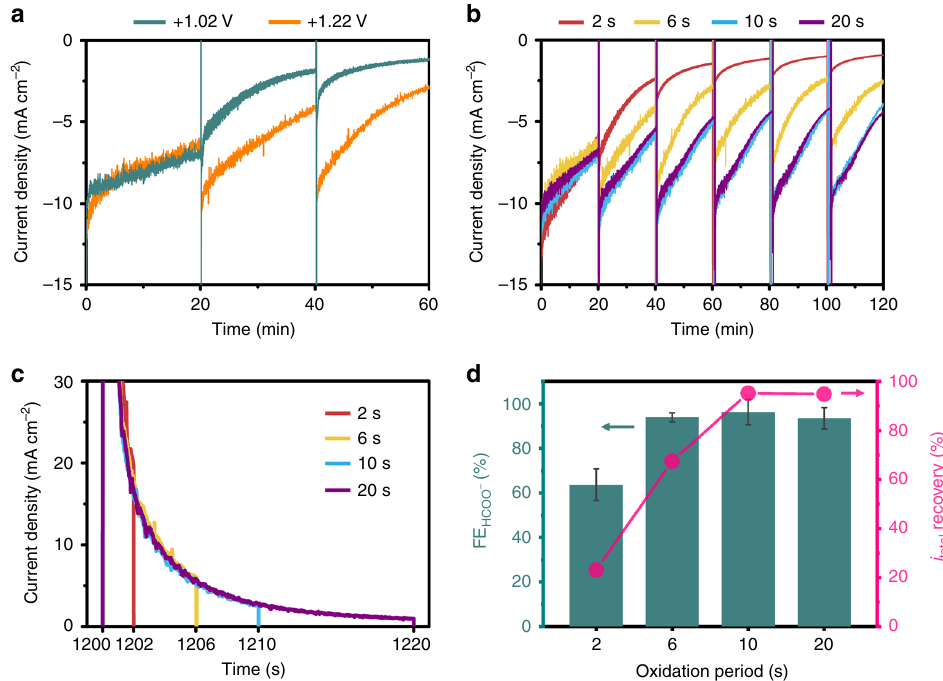
Fig. 4 Key parameters of cyclic two-step electrolysis. a The effect of oxidation potential on current density recovery. The oxidation potential was changed with the oxidation period fi xed at 6 s. b Current density vs. time curves as a function of oxidation period. The oxidation period was varied from 2 to 20 s while the oxidation potential was fi xed at 1.22 V vs. RHE. In controlling the oxidation parameters, the reduction potential and period were fi xed to − 0.18 V vs. RHE and 20 min. c Current density vs. time curves of the oxidation step with various oxidation periods. d The dependence of the current density ( j total ) recovery and the HCOO − Faradaic ef fi ciency (FE) on the oxidation period. The HCOO − FE was measured using 1 H nuclear magnetic resonance (NMR) analysis of the liquid product after cyclic two-step electrolysis. The j total recovery values were calculated by dividing the initial current density of the sixth cycle by that of the fi rst cycle in Fig. 4b. Error bars: mean±s.d. Source data are provided as a Source Data fi